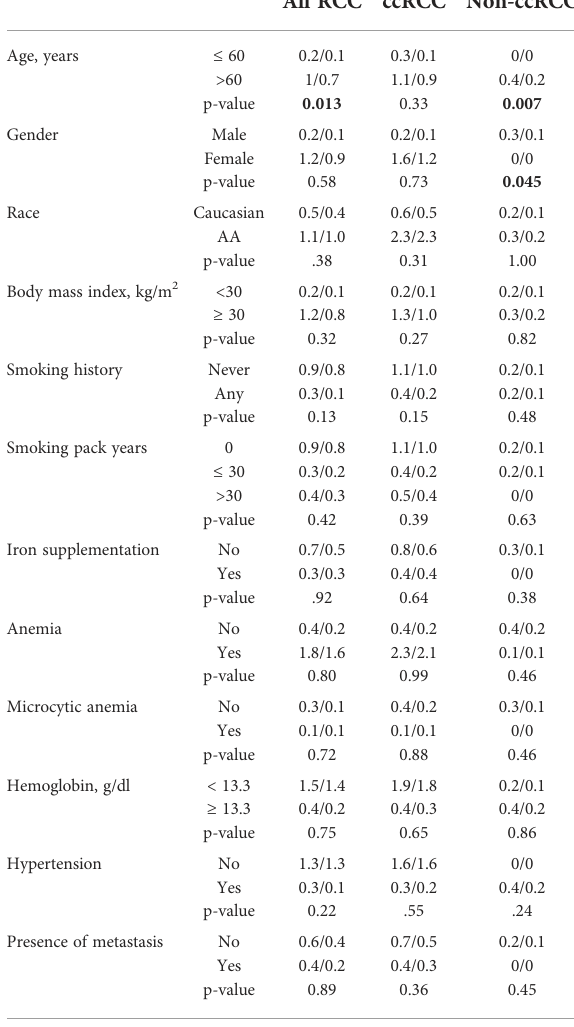
TABLE 5 Association between benign renal epithelial iron levels and RCC patient clinical features. Benign renal epithelium iron level (mean